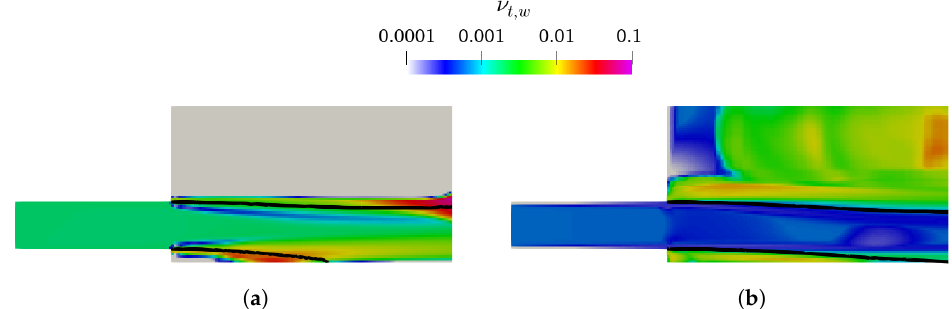
Figure 14. ν t , w at vertical central plane of the CTPE model with R m = 20; interface ( α = 0.5, black